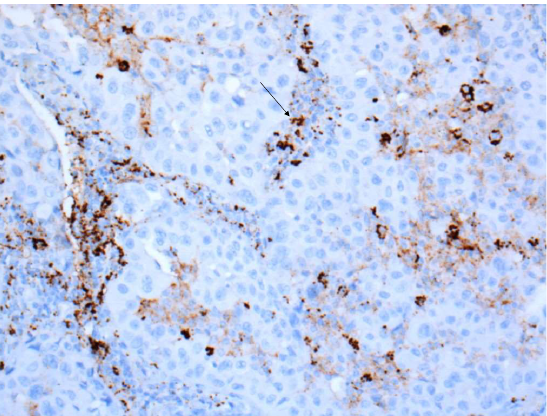
Figure 3. Tumor with PD-L1-positive immune cells, which often show a cytoplasmic staining (arrow) (40 × Obj.).